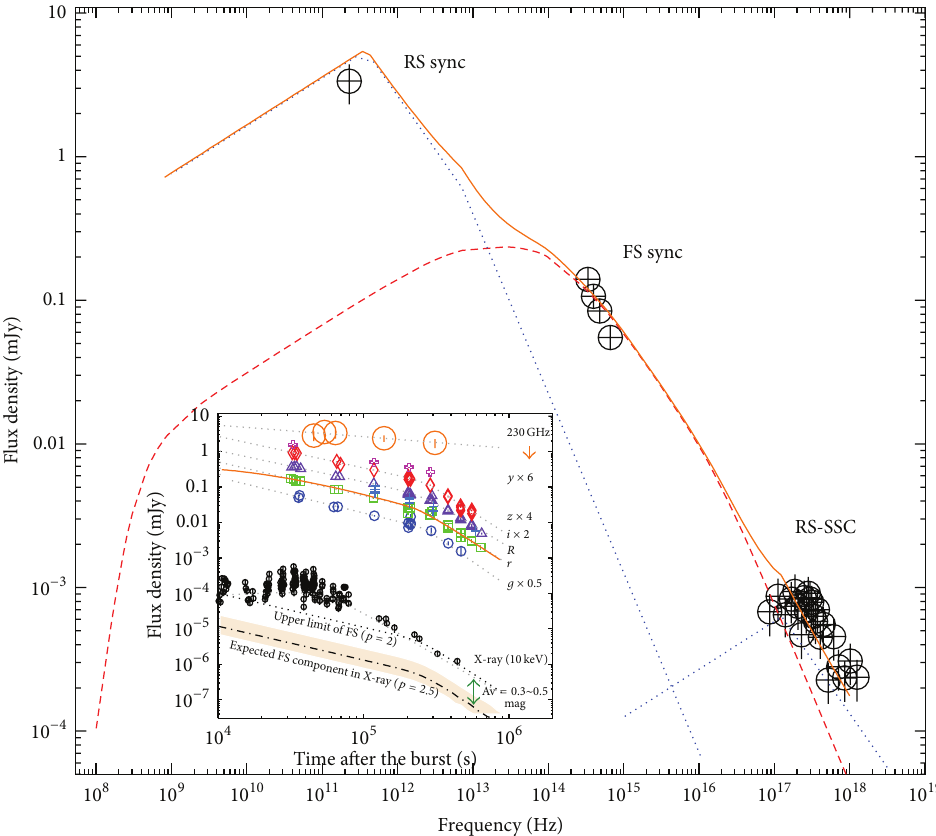
Figure 3: Main panel: The spectral energy distribution of GRB120326A at 6.42 × 10 4 s after the burst [18]. The red dashed line shows the forward shock synchrotron model spectrum calculated using the boxfit code [89] with the same parameters for the best modeling light curve showninthesubpanel.Thebluedottedlinesshowthereverseshocksynchrotronradiationanditsself-inverseComptoncomponentcalculated based on Kobayashi et al. [72] using the observed values and model function for the forward shock component. Subpanel: X-ray, optical, and submm light curves of the GRB120326A afterglow. The grey dotted lines show the best analytical fitted functions described in the text. The orange solid line shows the best modeling function for the 𝑟 -band light curve obtained with the numerical simulation using